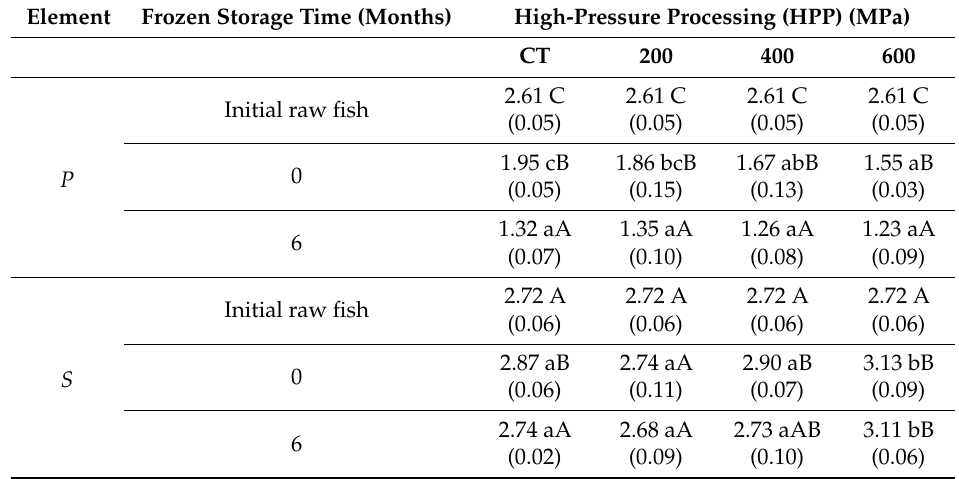
Table 5. Determination (mg · kg − 1 dry muscle) of di ff erent non-metal elements ( P and S ) contents * in initial raw fish and canned mackerel subjected to di ff erent processing conditions **. Element Frozen Storage Time (Months) High-Pressure Processing (HPP)